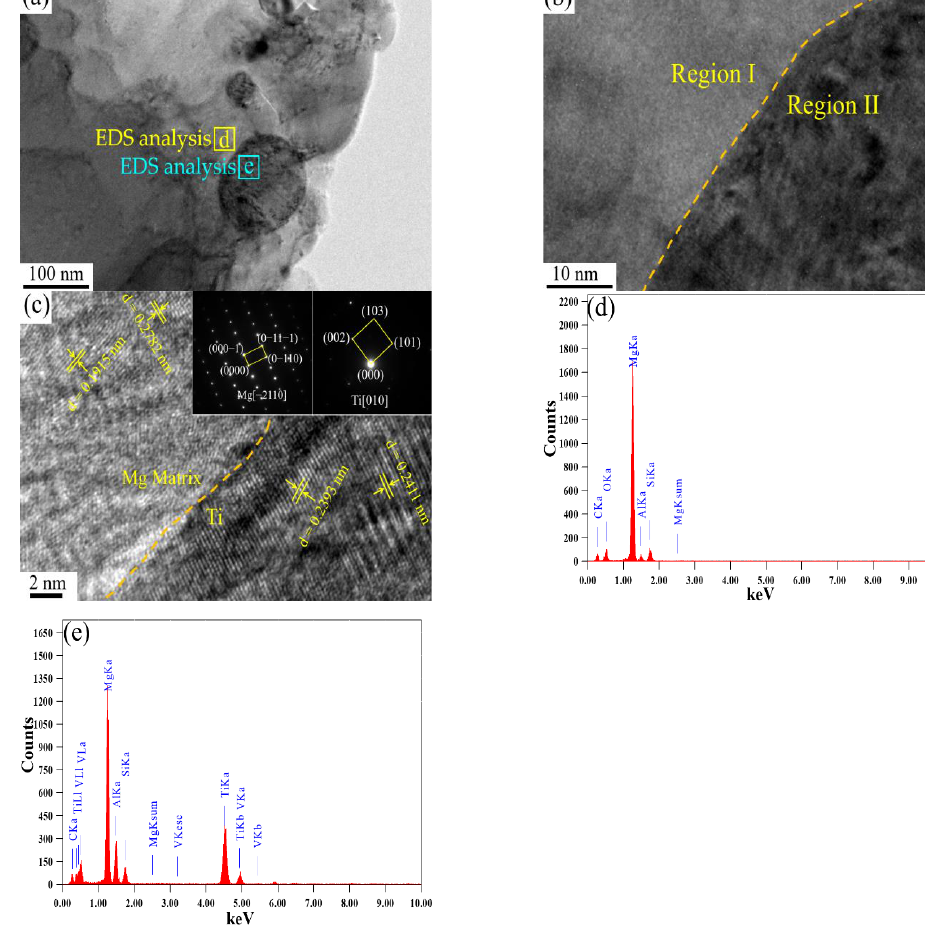
Figure 10. Interfacial structure of as-extruded 1 wt.%TC4/AZ31 composite: ( a ) TEM image; ( b ) HRTEM image; ( c ) Ti/Mg interface; ( d ) EDS analysis in position d; ( e ) EDS analysis in position e.